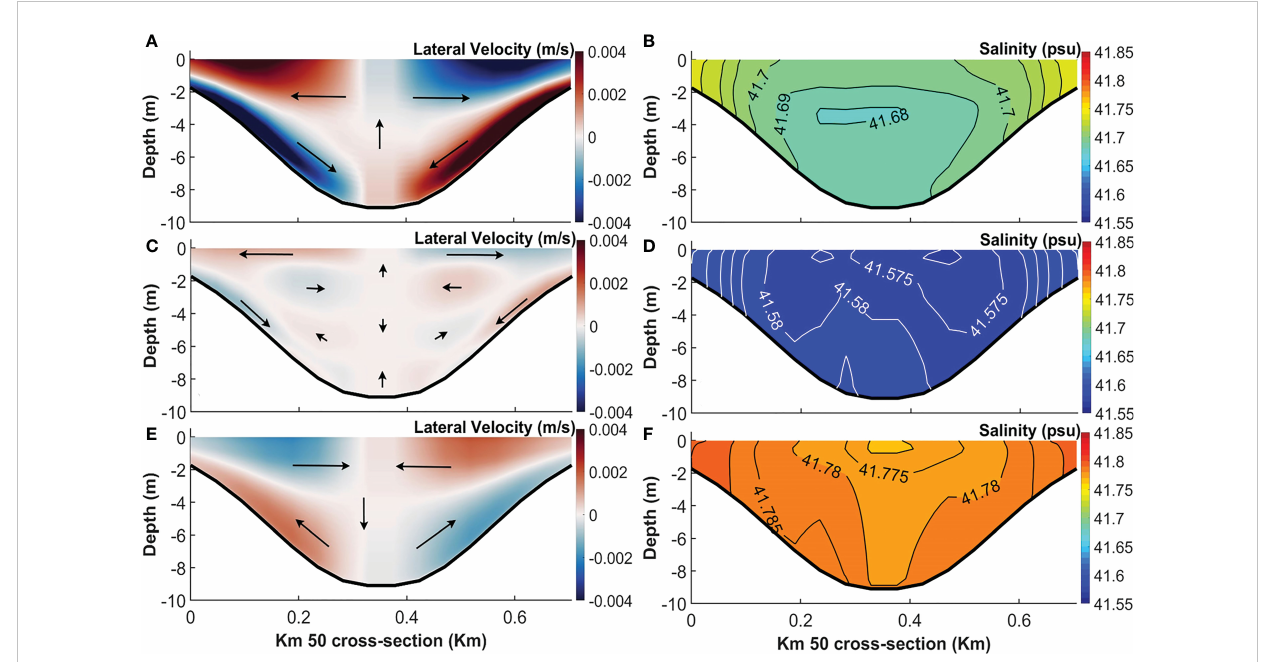
FIGURE 6 The time-averaged lateral velocities (A, C, E) and salinities (B, D, F) along the cross section at 50 km during neap tide (A, B) , full neap – spring cycle (C, D) and spring tide (E, F) from EXP3. Red and blue colors in velocities identify leftward and rightward velocities, respectively, looking into the